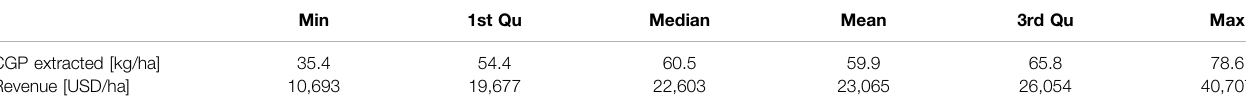
TABLE 3 | CGP yield per hectare distribution [kg/ha] and CGP revenue per hectare distribution